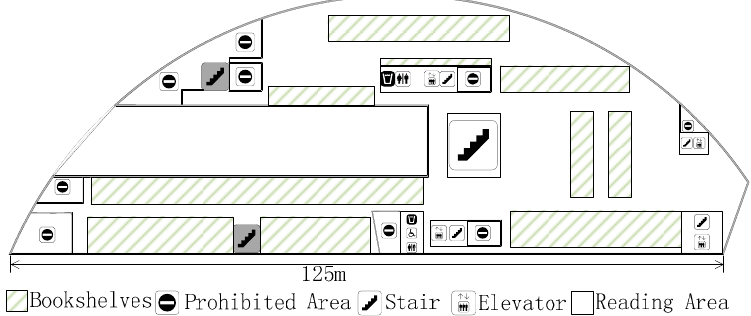
Figure 6. Plane graph of the fourth floor in the Northwestern Polytechnical University (NWPU) campus library.